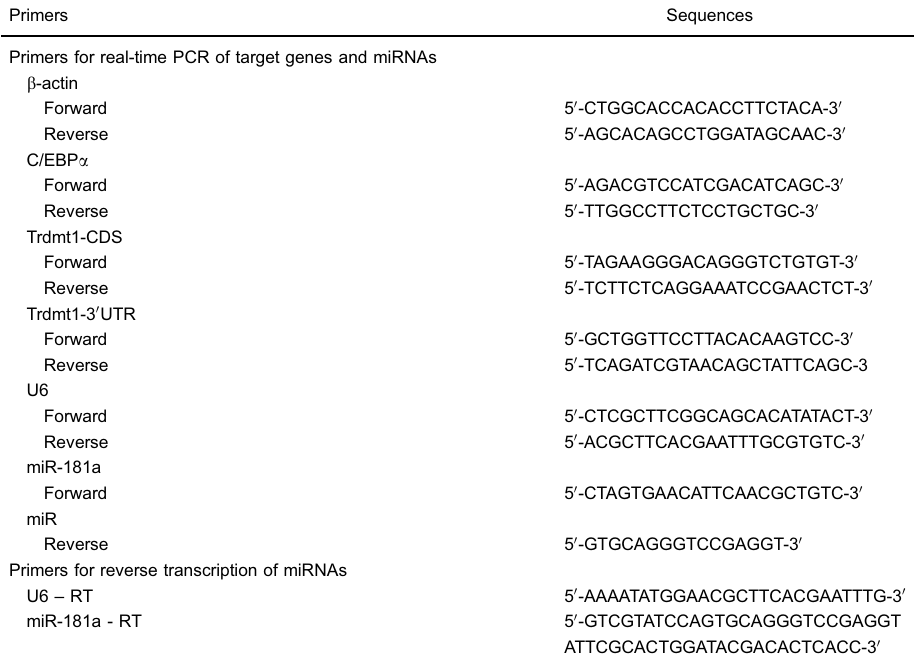
Table 1. Sequences of primers used in this study.